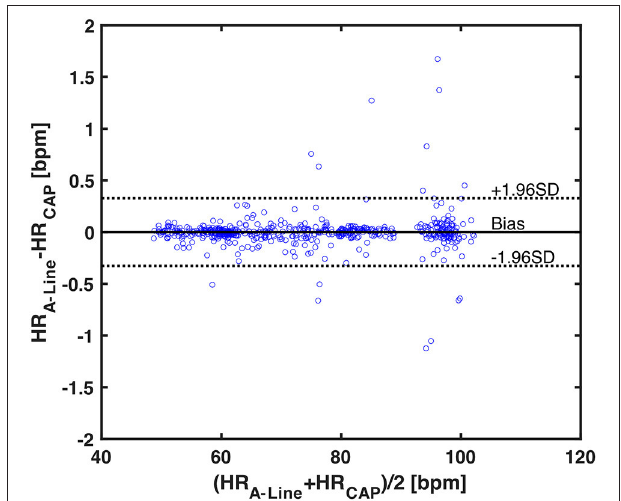
FIGURE 5 | A Bland-Altman plot of 562 averaged heart rates calculated from 30-s valid segments across 17 patients. Each blue circle is one averaged HR data. The black horizontal solid and dotted lines represent the mean bias and the upper and lower 95% limits of agreement, respectively. The mean bias in differences is 0.0006, upper 95% limit is 0.3272, and lower 95% limit is −